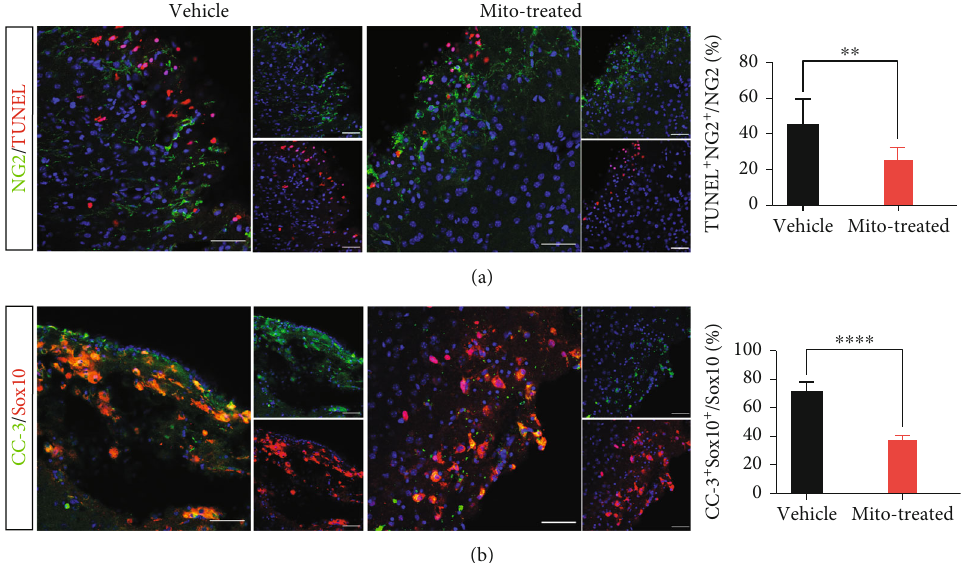
Figure 2: E ff ects of grafted mitochondria on the survival of OPCs. (a) Combination of TUNEL and NG2 staining at 3d posttransplantation. (b) Double immunostaining of cleaved caspase-3 (CC-3) and Sox10 at 3d posttransplantation. TUNEL/NG2- and CC-3/Sox10-positive cells were signi fi cantly decreased in mitochondria-treated mice, as compared to control. Representative images were taken from lesion boarder.